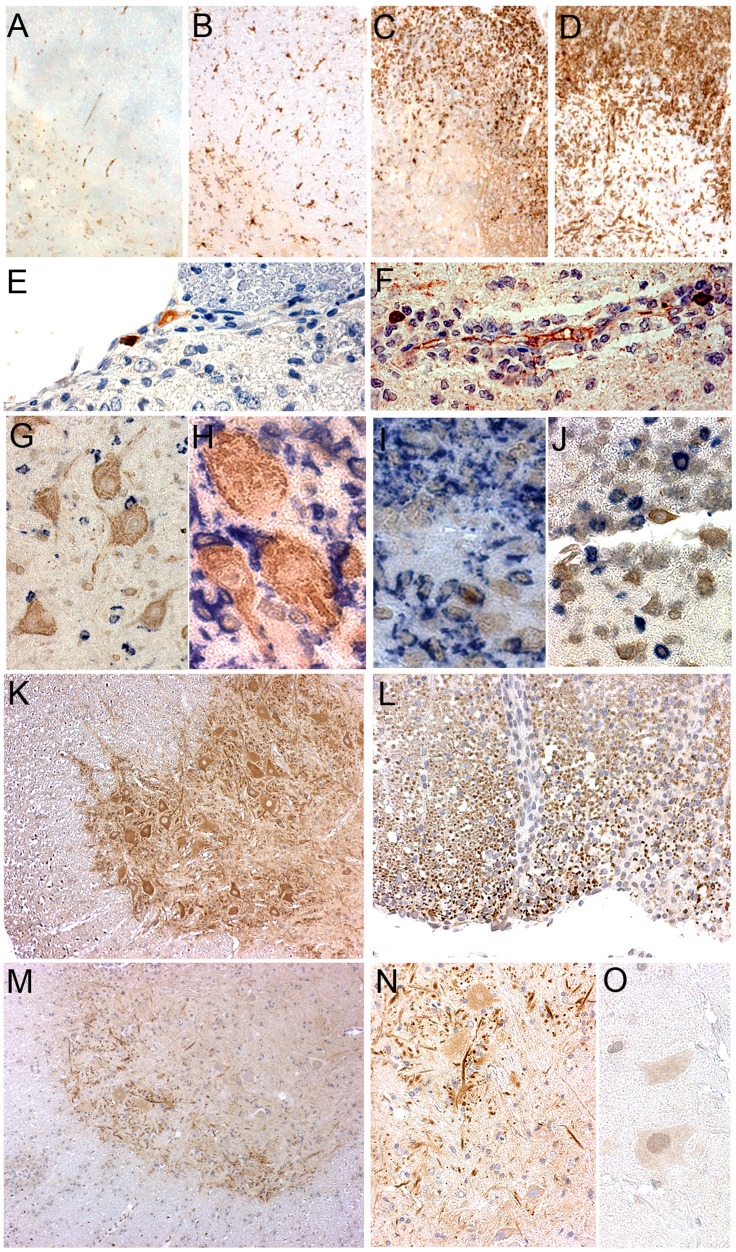
CCL11 and CCR3 expression in the central nervous system of Eae18b congenic rats.(A–D) Congenic and control group representative spinal cord cross sections stained for ED1 (A, C) and Iba-1 (B, D), both hallmarks for activation of microglia/macrophages (brown). Control rats (C, D) showed upregulation of both markers in contrast to congenics (A, B). (E, F) Portions of the control spinal cord cross section showing IgG+ single positive (golden brown, E) plasma cell and CCL11+/IgG+ double positive (maroon; E, F) plasma cells. (G, H) Congenic spinal cord; ventral horn gray matter portion showing CCL11 in neuronal pericarya, dendrites and axons (brown) together with co-stained ED1+ (G) or Iba-1+ (H) cells (both in blue). (I) Congenic spinal cord portion presenting solitary CCL11+ (golden brown)/ED1+ (blue) macrophage on the inflammation site. (J) CCL11+ plasma cell (golden brown) not co-localizing with CD3+ T cells (blue), here in the control spinal cord cross section. (K) Ventral horn of the congenic spinal cord gray matter not undergoing inflammation showing CCR3 upregulation in neurons, dendrites and axons (brown). (L) Dorsal spinal cord white matter expressing CCR3 (dark brown dots), partially downregulated within demyelinated lesion on the right side of the image. (M, N) Ventral horn of the congenic spinal cord gray matter undergoing inflammation revealing CCR3 downregulation in neurons (brown, in the lower (M, 40×) and a chosen detail in the higher magnification (N, 160×). (O) Negative control; a detail representing resident cells in the ventral horn of the spinal cord gray matter.